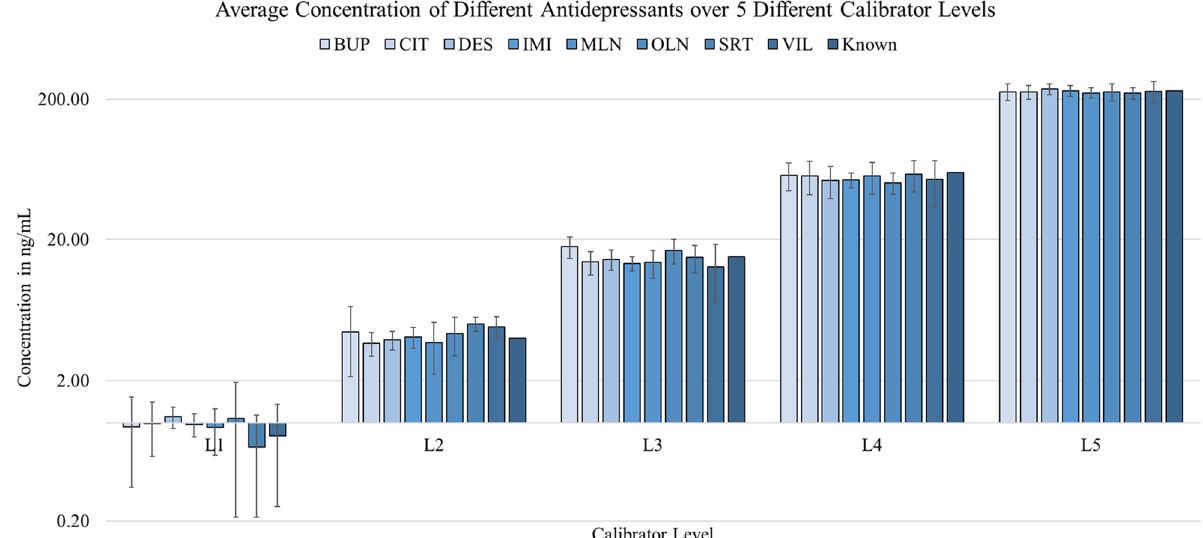
Figure 3. Average concentration alongside the theoretical concentration of the calibrators. Error bars indicate standard